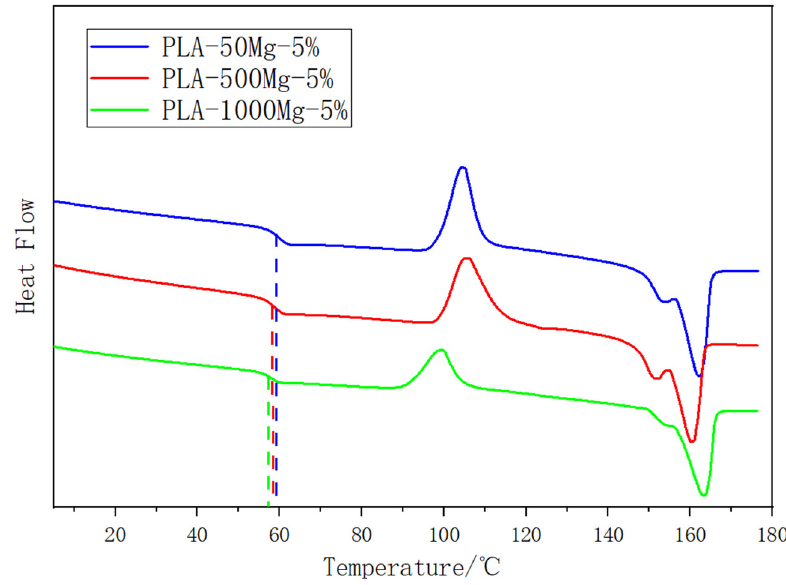
Figure 4. DSC of PLA/MgO composites with different particle sizes of MgO. Table 1. Melting heat and crystallinity parameters of MgO with different particle sizes.